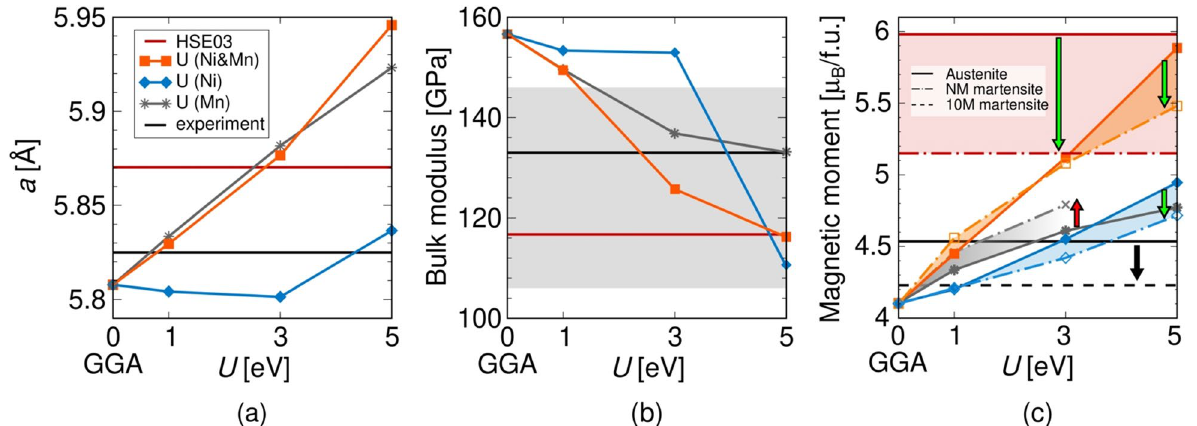
Figure 2. ( a ) Relaxed austenite lattice constant as a function of U applied to different sites compared with HSE03 and experimental value 6 , ( b ) bulk modulus calculated using HSE03 and DFT +U (colour lines) compared with experiments (black line 51 and grey area 13,51,52 ), and ( c ) total magnetic moments calculated using HSE03 and DFT +U compared with experimental value measured on modulated martensite 6 . Solid lines represent cubic austenite (in ( c ) panel the black solid line belongs to extrapolated value) and dash-dotted/ dashed lines belong to NM/10M martensite. Both HSE03 and U on Ni predict larger total magnetic moment of austenite comparing to NM martensite at 0